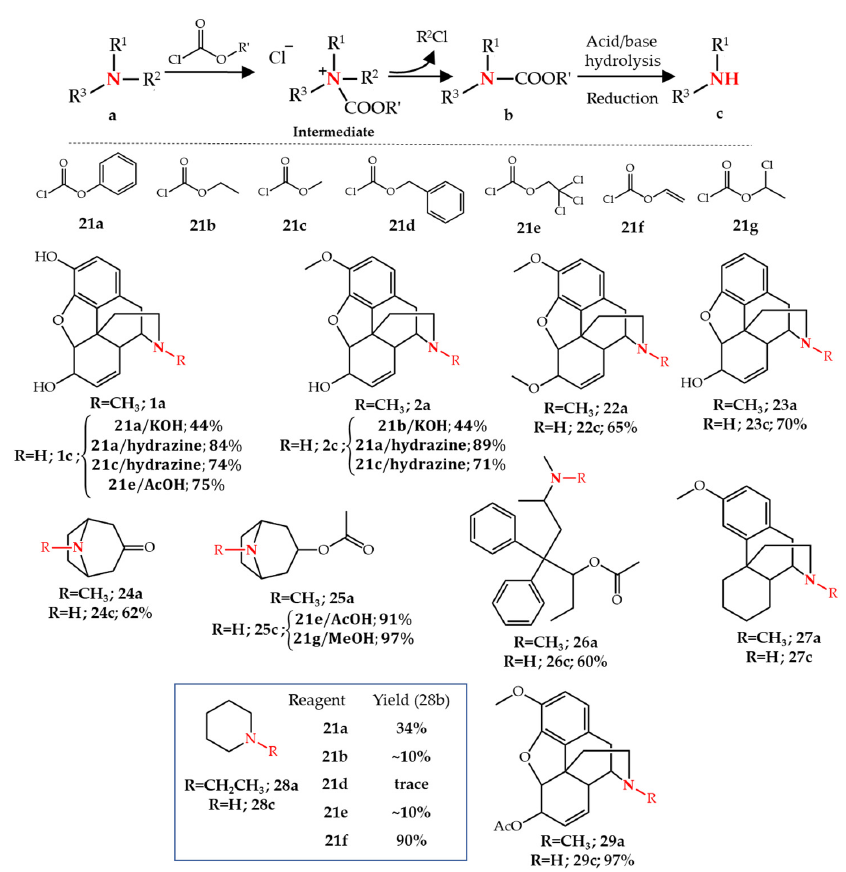
Figure 3. N ‐ Dealkylation of amines by chloroformates. Figure 3. N -Dealkylation of amines by